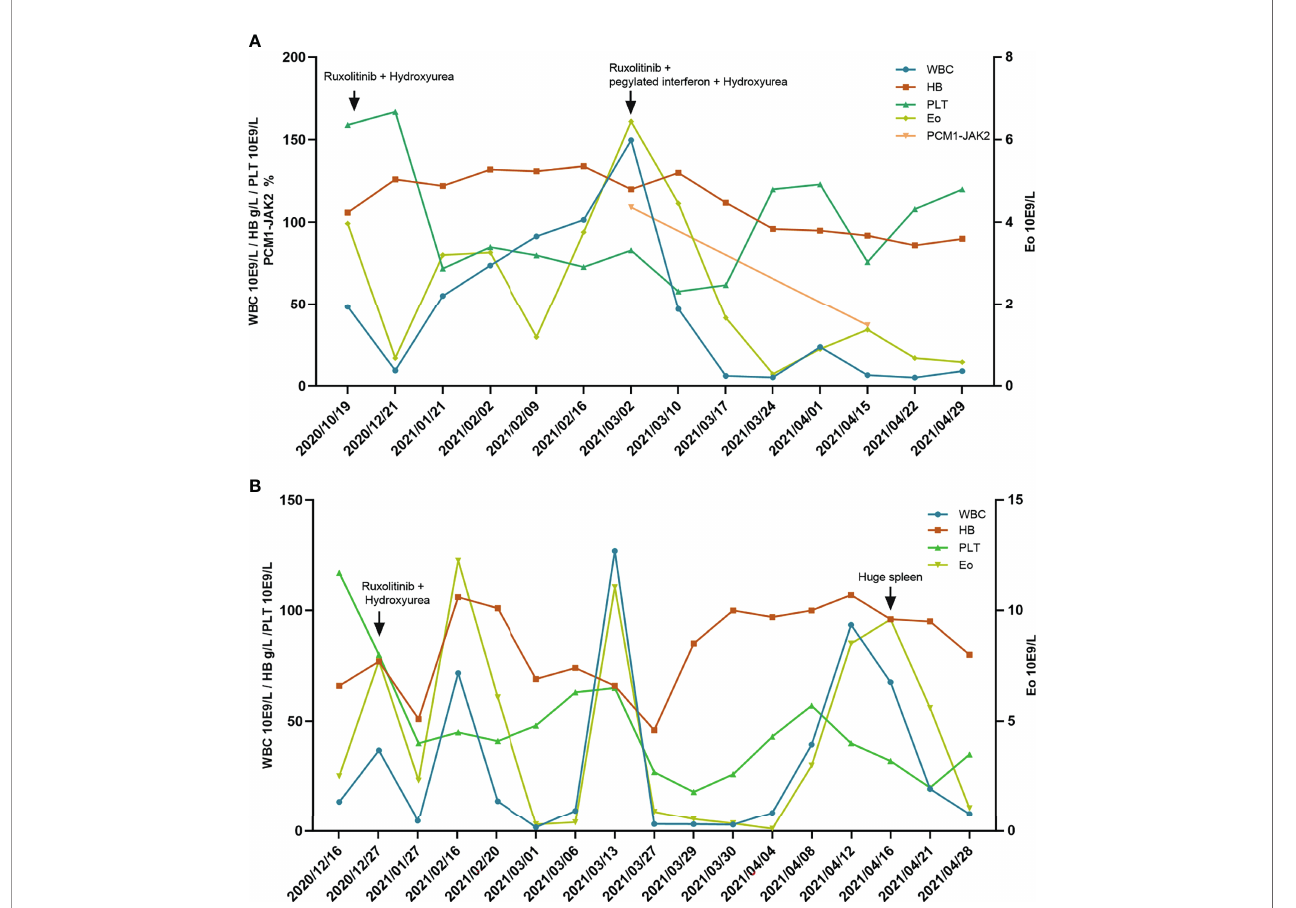
FIGURE 1 | (A) The blood cell and PCM1-JAK2 fusion transcript changes in patient 1 over the course of the disease. (B) The blood cell changes in patient 2 over the course of the disease. WBC, white blood cells; HB, hemoglobin; PLT, platelet; Eo,